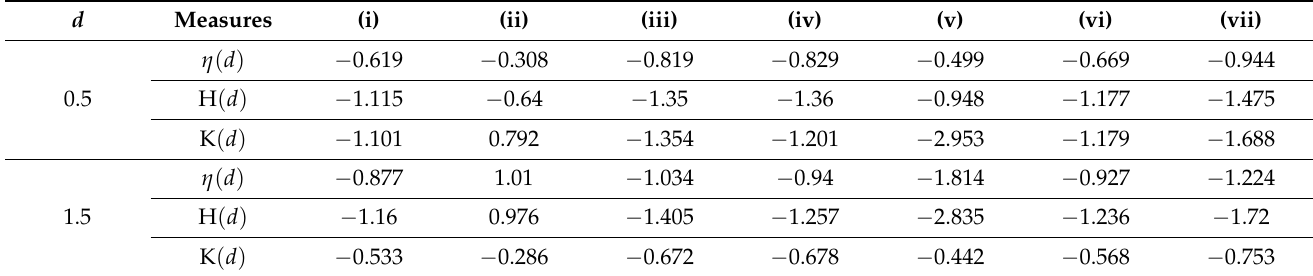
Table 2. Numerical values for the UPBXD’s entropy